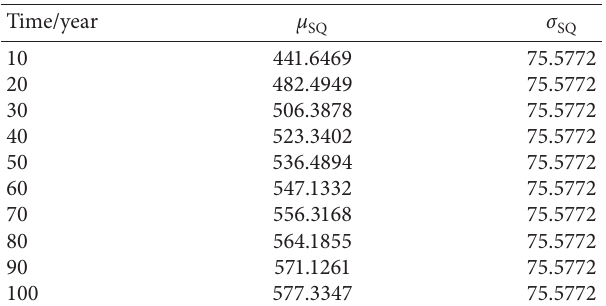
Table 3: Mean and standard deviation of the vehicle load (kN · m). Table 4: The beam time-dependent reliability